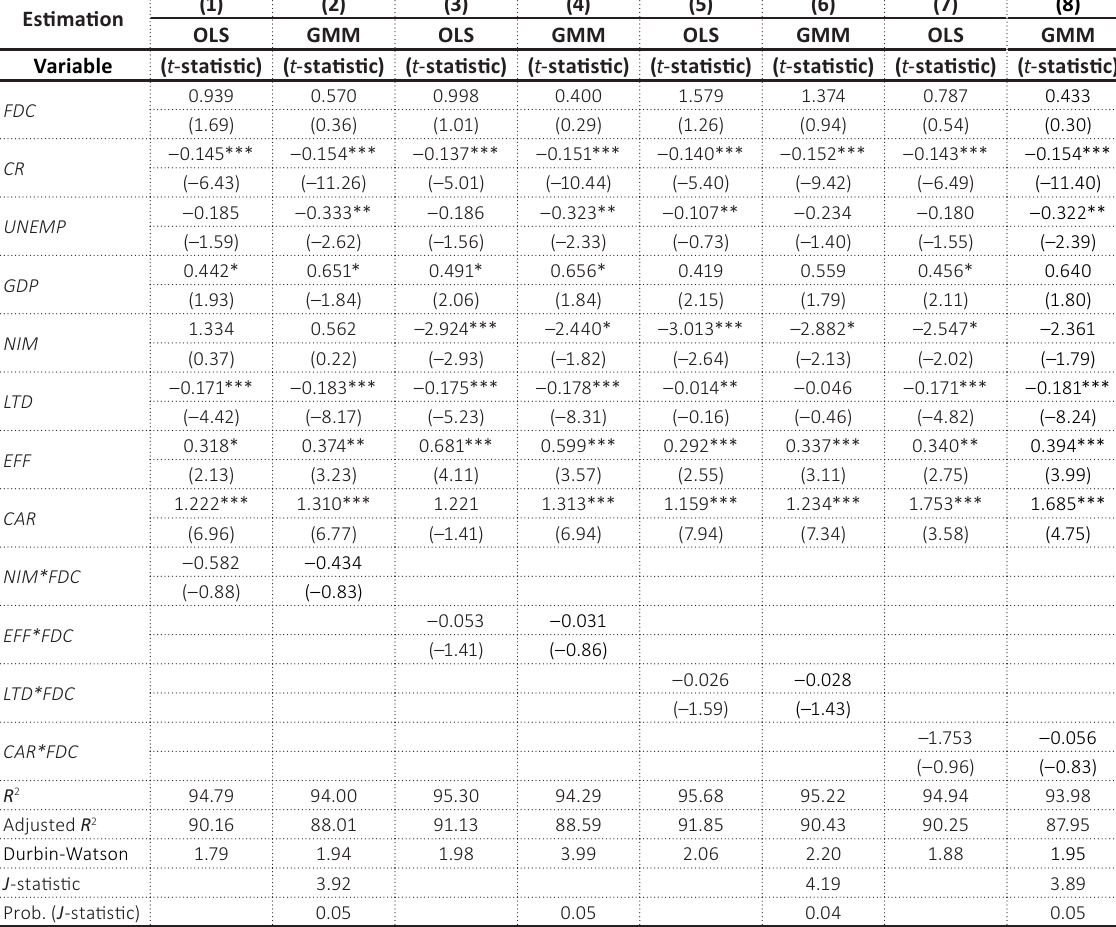
Table 10. Joint-effect of FDI per capita and banking sector characteristics on NPLs